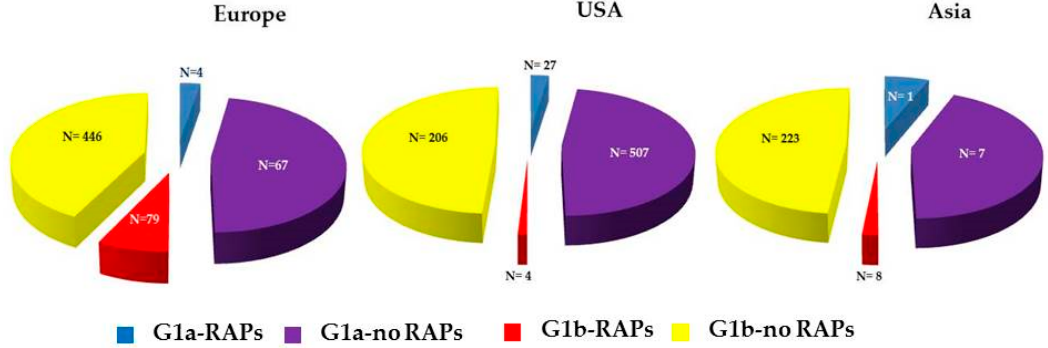
Figure 2. Frequency of RAPs according to geographic origin of HCV genotypes (G1a,